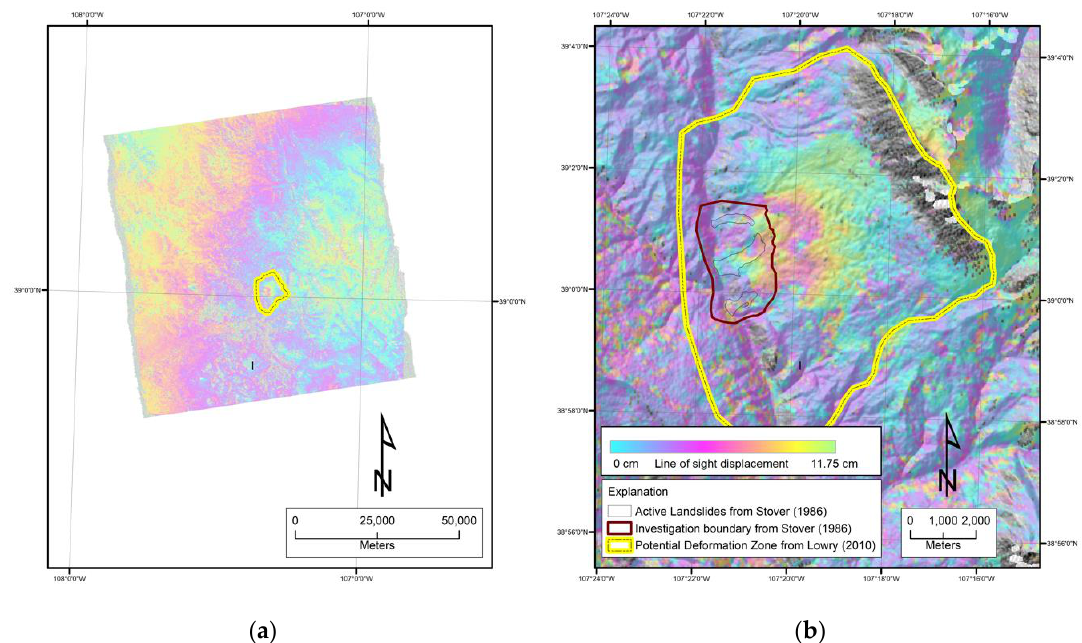
Figure 7. ( a ) Stacked interferogram generated from 2007 to 2011 ( b ) ALOS-1 Stacked deformation between 2007 and 2011 indicating clear displacements beyond previously mapped landslide activity (modified from [51]).